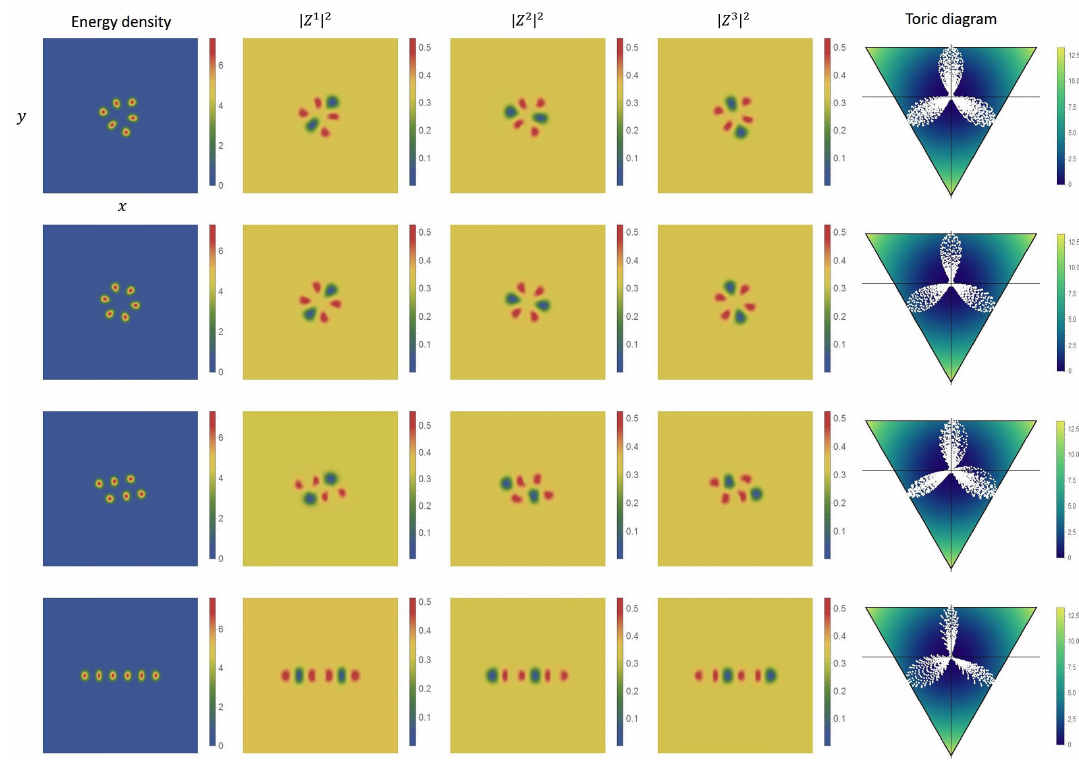
Figure 3 . The energy density, the norm of the homogeneous coordinates, and the toric diagram of the Q = 2 solutions. For more details, see the caption of figure